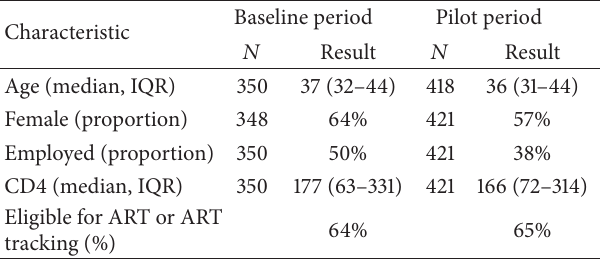
Table 1: Study sample demographic and clinical characteristics at the time of testing HIV-positive ∗ .